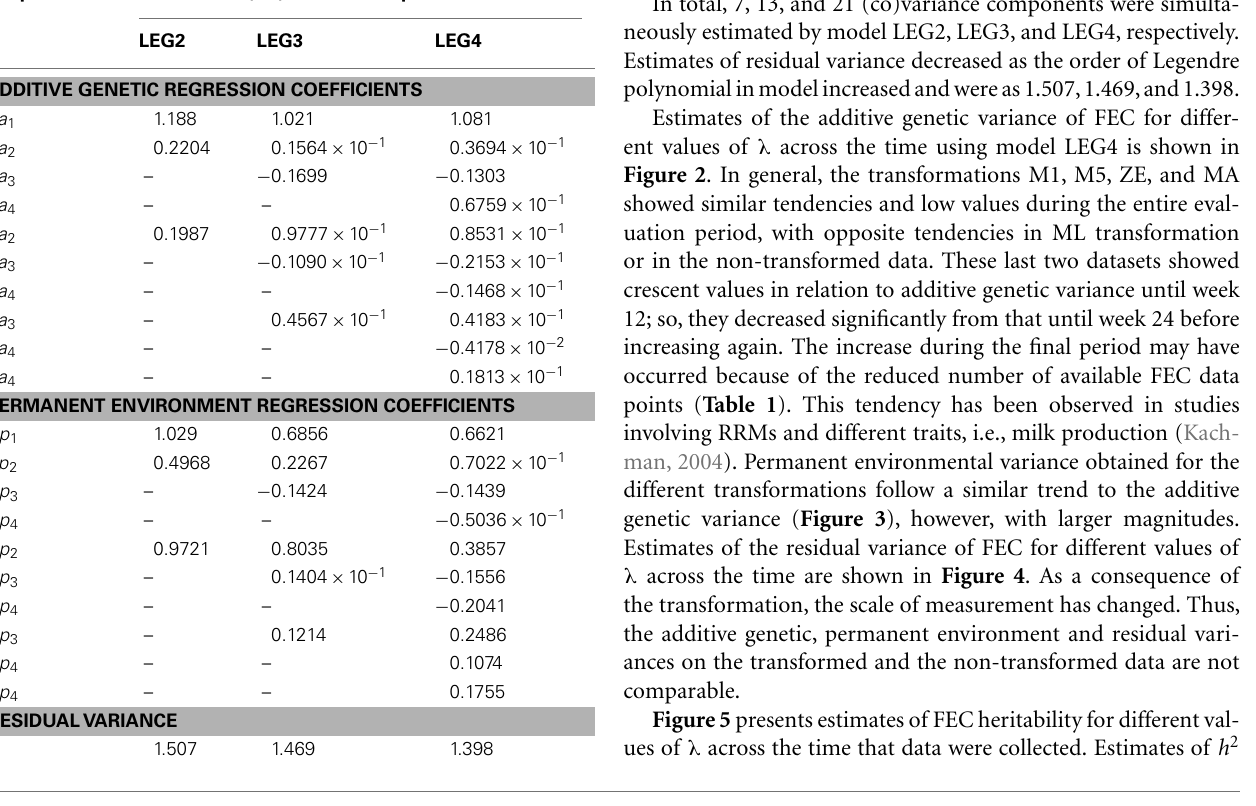
Table 5 | Number of parameters (NP), − 2log value of the likelihood function ( − 2log L),Akaike (AIC), and Bayesian information criterion (BIC), according differents random regression